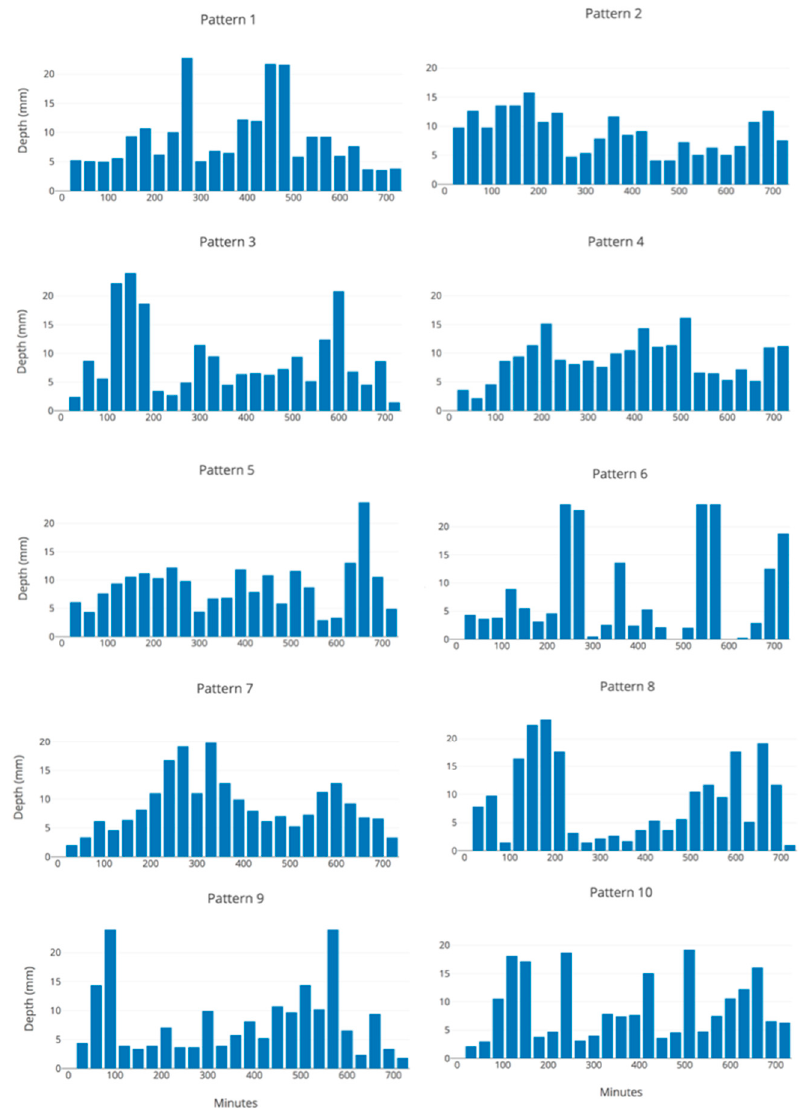
Figure 6. Design rainfall patterns for 5% AEP 12 h storm.